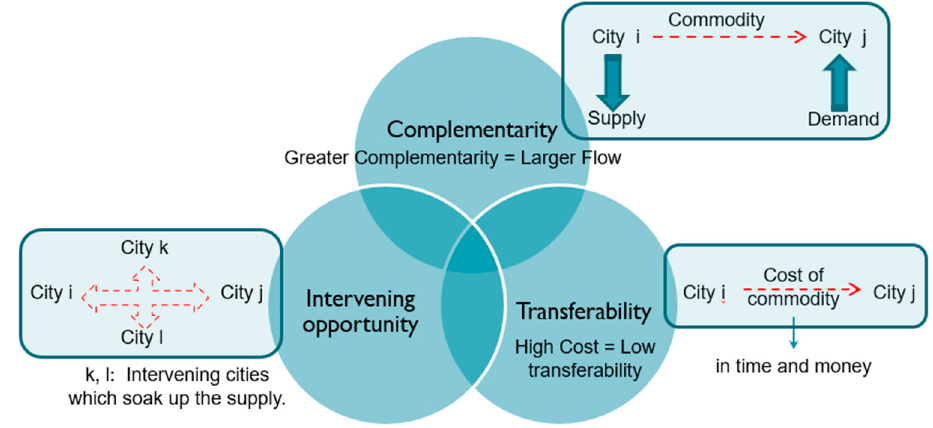
Figure 2. An illustration of Ullman model of commodity transfers (adapted from [34]).